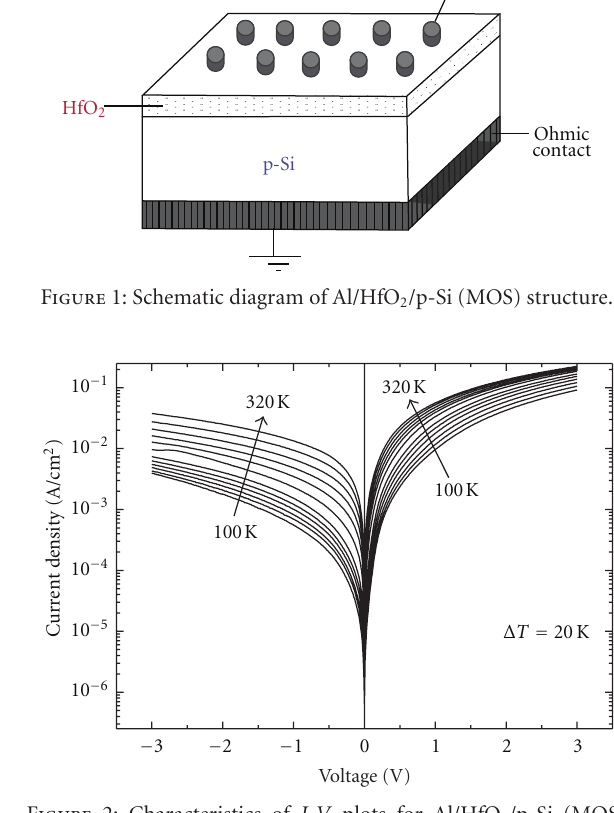
Figure 2: Characteristics of J-V plots for Al/HfO 2 /p-Si (MOS) structure at various